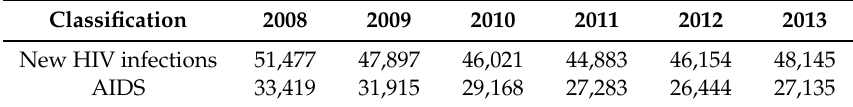
Table 1. Estimated numbers for HIV/AIDS, by year of diagnosis, United States (2008–2013).